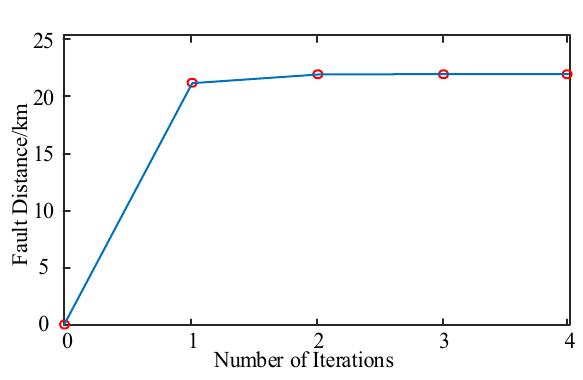
Figure 12. Convergence of iterative algorithms.